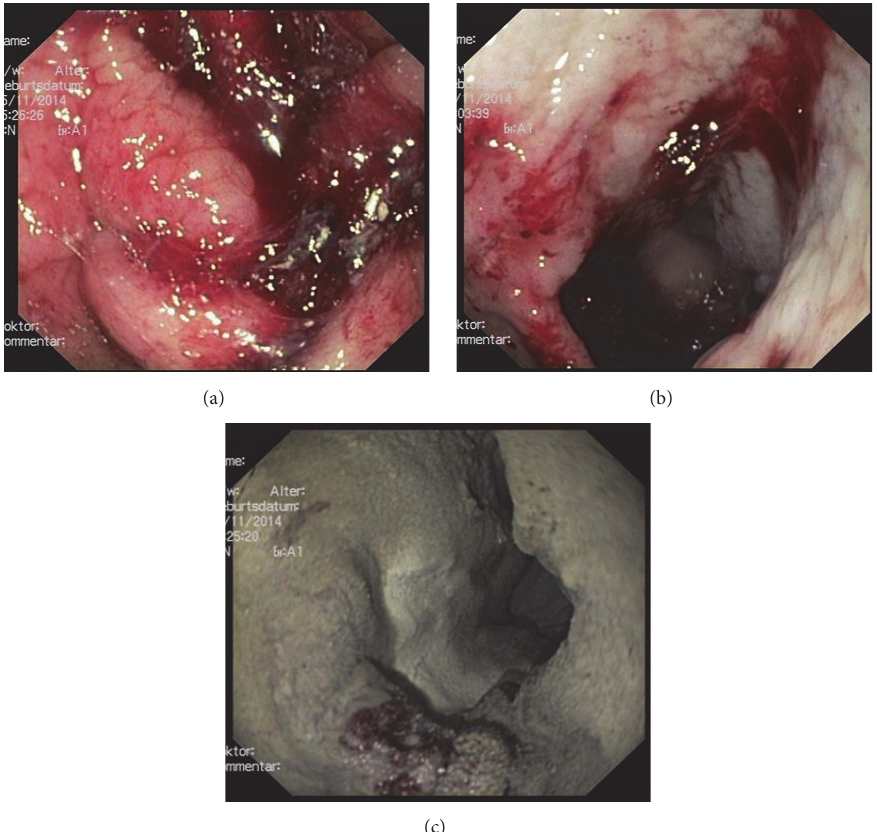
Figure 1: (a)–(c): acute antral bleeding (a), which cannot be terminated by injection of diluted epinephrine solution (200mL in total) (b). After the application of Hemospray, hemostasis can finally be achieved